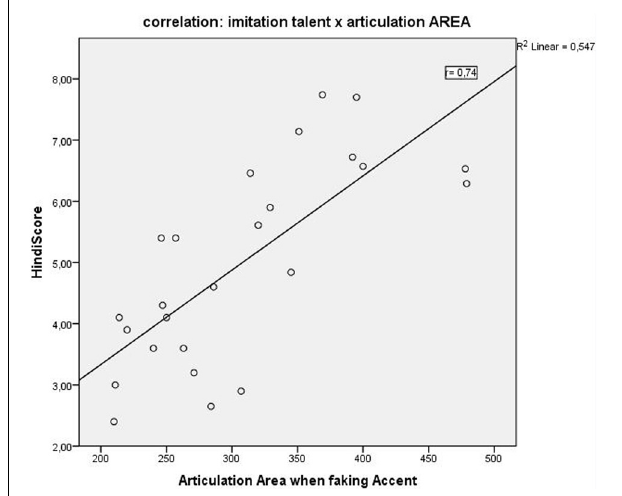
FIGURE 6 | Group vs. group comparisons: significant differential activations (low ability > high ability group) for the low ability group during sentence reading in (A) German (L1), (B) English (L2) and (C) German with fake English accent (L1Acc). (A) FWE corrected (whole brain) for multiple comparisons at cluster level, p < 0 . 05. Cluster extent threshold k = 400 voxels (only clusters which exceed this number are displayed).